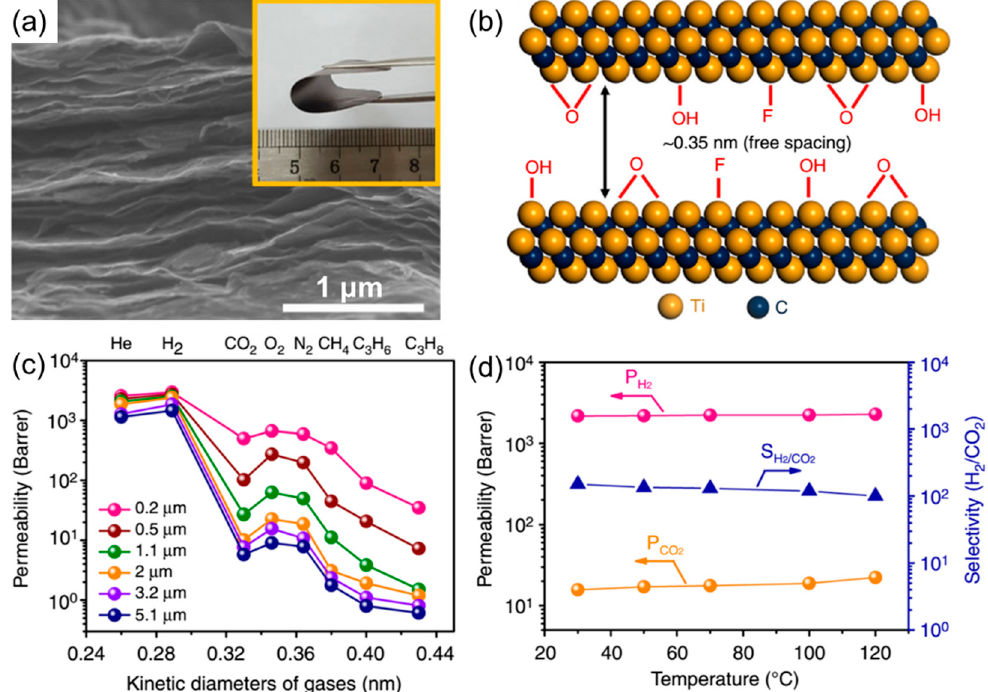
Figure 7. ( a ) Cross-sectional SEM image of a MXene membrane. Inset is a bent membrane. ( b ) Illustration of a nanochannel between two nanosheets. ( c ) Effect of the film thickness on the gas permeability of MXene membranes. ( d ) Mixed-gas H 2 /CO 2 separation performance of a 2-µm-thick MXene membrane at 30–120 °C. Adapted with permission from [30].